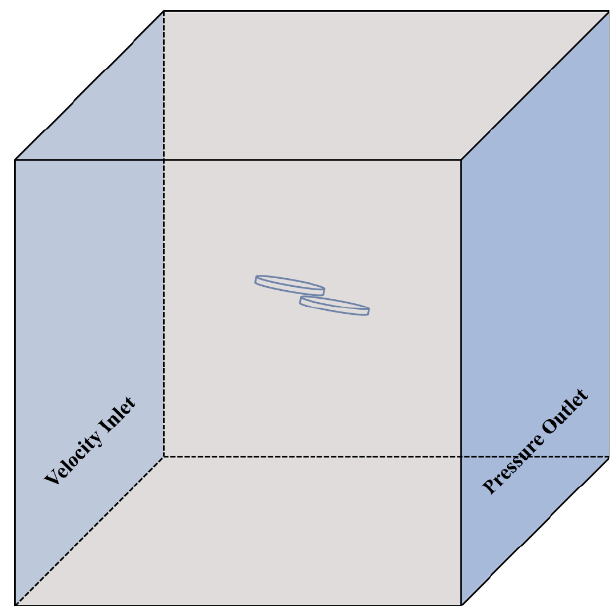
Figure 11. Computational region.